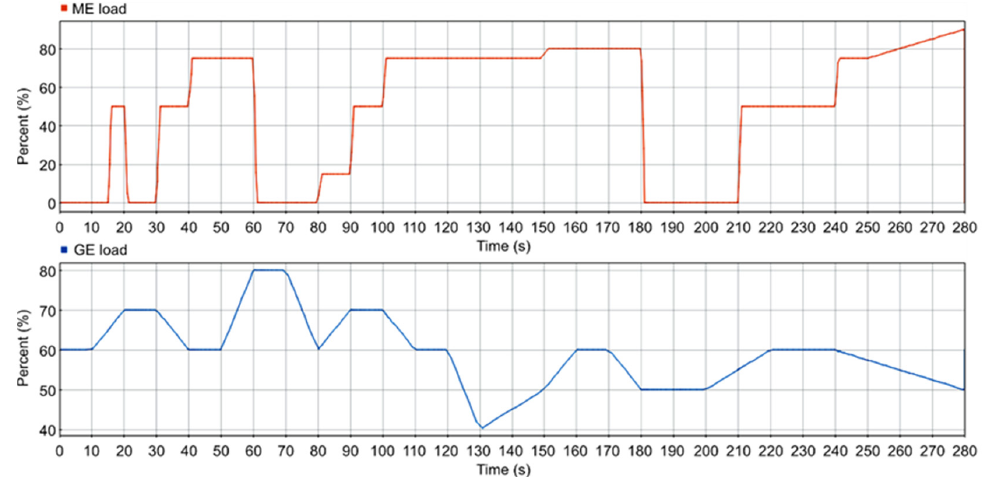
Figure 6. Variable input of M/E and G/E load.